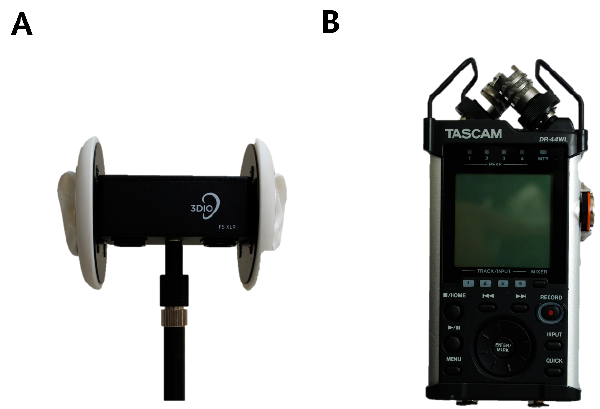
Figure 1. Equipment used for recording: ( A ) Binaural microphone Free space (3DIO, Vancouver, Canada); ( B ) Record controller DR44WL (Tascam, Santa Fe springs, CA, USA).